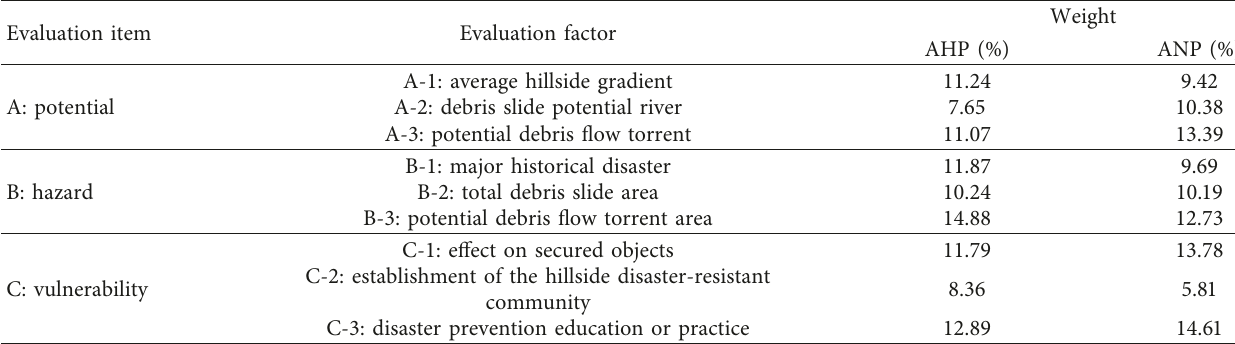
Table 9: Weights of evaluation factors using the AHP and